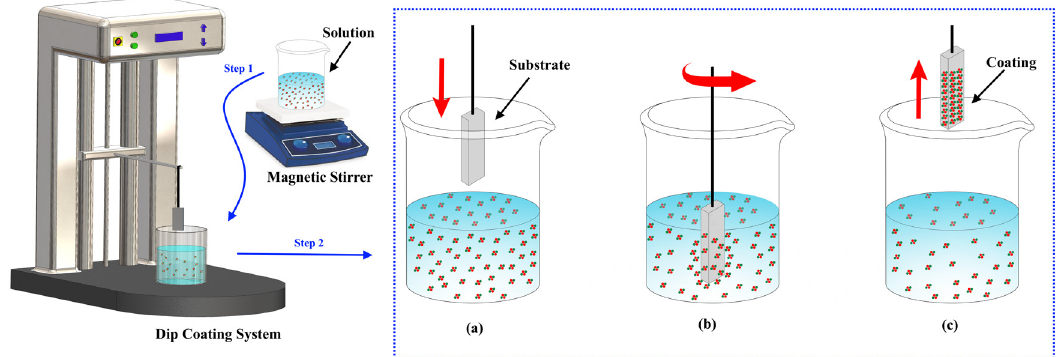
Figure 1: The schematic representation of the dip - coating process. ( a ) Dipping, ( b ) formation of polymer layer, and ( c )